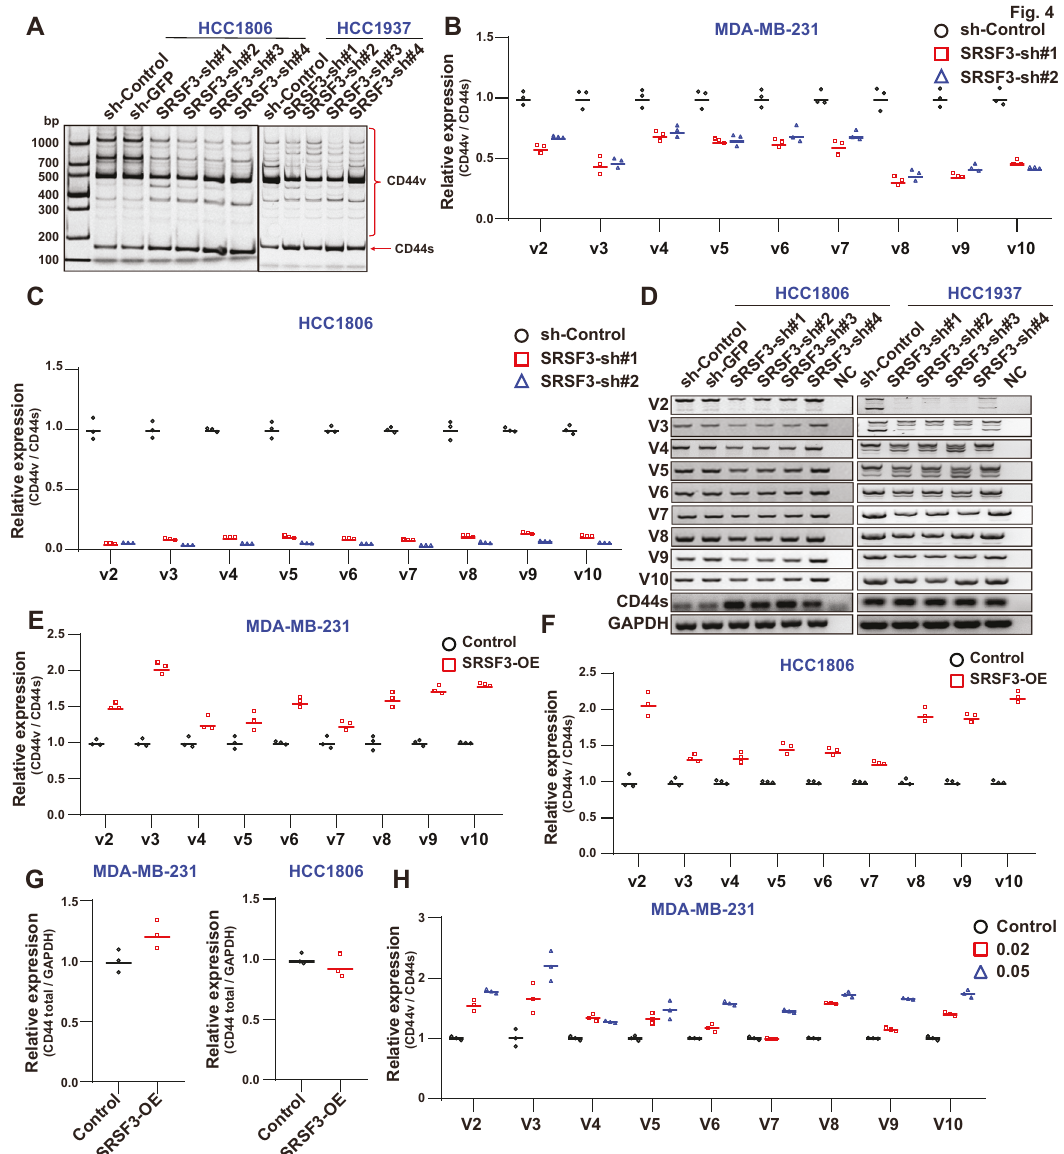
Fig. 4 SRSF3 regulates CD44 AS in breast cancer cells. A Semi-quantitative RT-PCR (CD44 RT-PCR) of CD44 isoforms after SRSF3 KD in HCC1806 and HCC1937 cells. B , C CD44v/s analysis by qPCR after SRSF3 KD. D CD44 splicing events veri fi ed by semi-quantitative